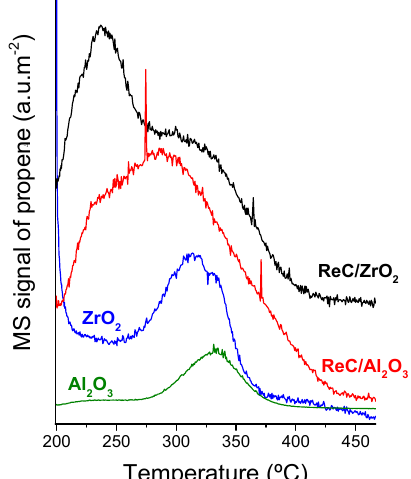
Figure 7. TPD-IPA profile of the supports alone and the resulting catalysts. It can be observed that in the case of the bare supports, propene is formed at around 320 ◦ C for ZrO 2 and 334 ◦ C for Al 2 O 3 . The lower temperature observed in the case In summary, catalysts characterization results provide clear evidence of support’s influence on the nature and dispersion of the active phase obtained after carburization. Over SiO 2 , the results suggest that Re 0 was mainly obtained and carburization was minor. Over ZrO 2 , it appears that Re x C was obtained together with Re 2 C. Finally, over Al 2 O 3 , the data suggest that Re 2 C and ReC x O y /ReO x may have been formed. The origin of these dif- ferences could reside in the acidity of the support. The desorption profiles of NH 3 indicate that SiO 2 has negligible acidity while Al 2 O 3 and ZrO 2 have acid sites of comparable strength. The TPD-IPA results indicate that ZrO 2 presented stronger BAS than Al 2 O 3 , which may have played a role in the formation of ReC with a higher amount of strong BAS. 2.2. Catalytic Properties The catalysts and the bare supports were evaluated for guaiacol HDO. Table 3 sum- marizes the initial rate of conversion (r 0 ) together with the CO uptakes. Negligible guaia- col conversion was obtained over the SiO 2 support, while appreciable conversions were observed over the ZrO 2 and Al 2 O 3 supports. The initial rates over the ZrO 2 support (9.5 × 10 − 6 mol g − 1 s − 1 ) was about two times higher than on the Al 2 O 3 support (4.8 × 10 − 6 mol g − 1 s − 1 ). Table 3. CO uptake and initial rate of guaiacol conversion obtained at 350 °C. SiO 2